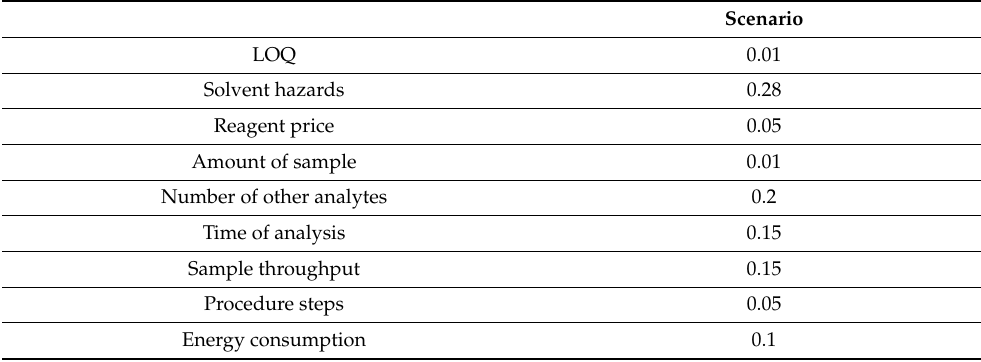
Table 2. Weights applied for TOPSIS according to the